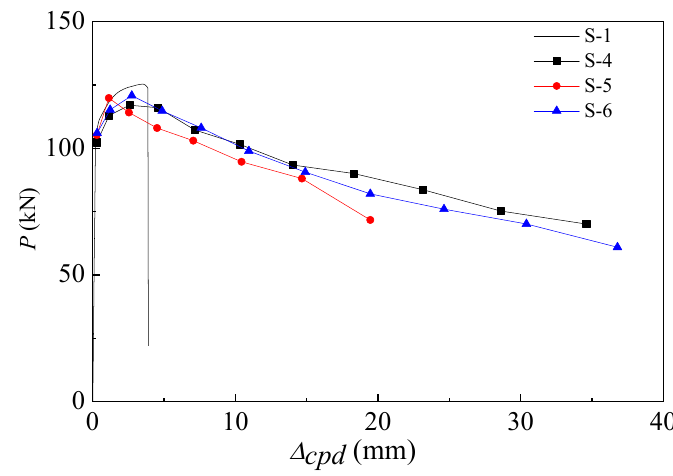
Figure 12. Skeleton curve with cumulative plastic displacement.